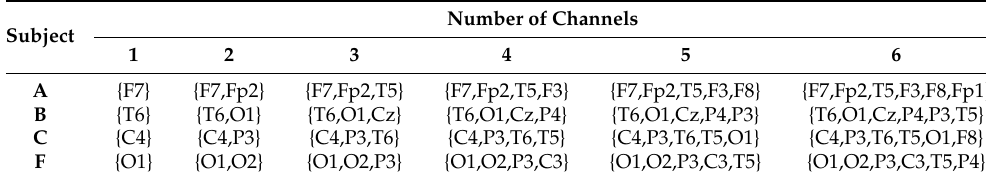
Table 11. Summary of the optimal channel